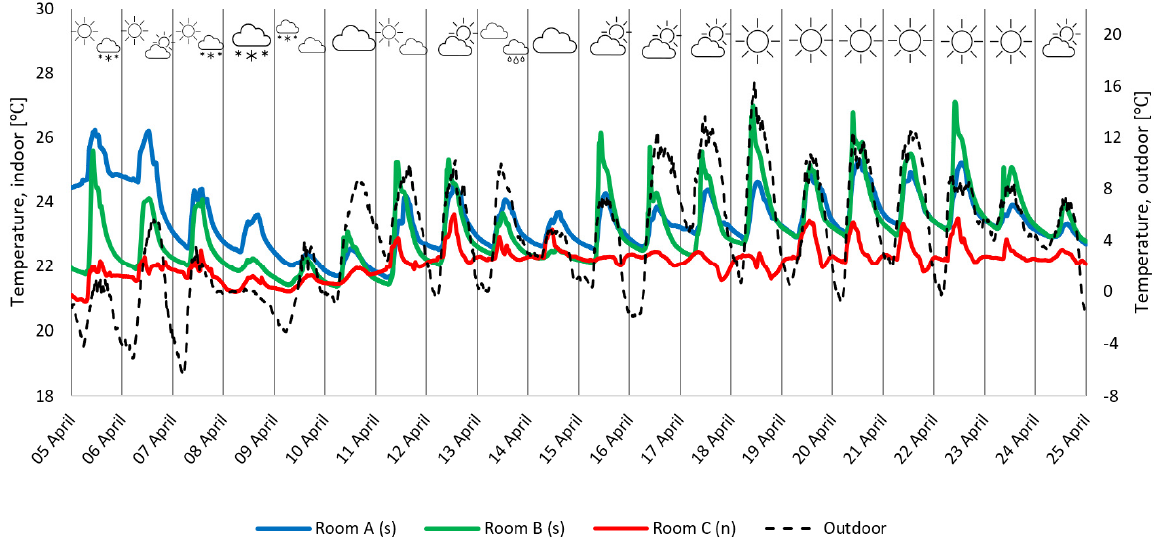
Figure 16. Comparison of indoor and outdoor temperatures and symbols of weather, with the indoor temperature of the three rooms shown on the left axis and the outdoor temperature on the right axis.